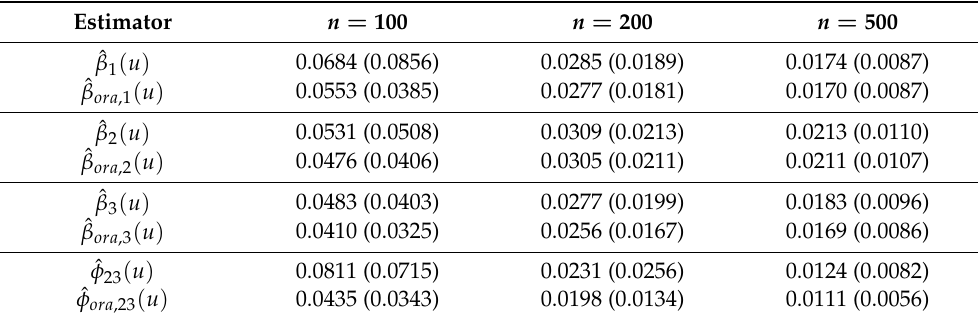
Table 1. MISEs of the functional coefficients estimators for Model 1.